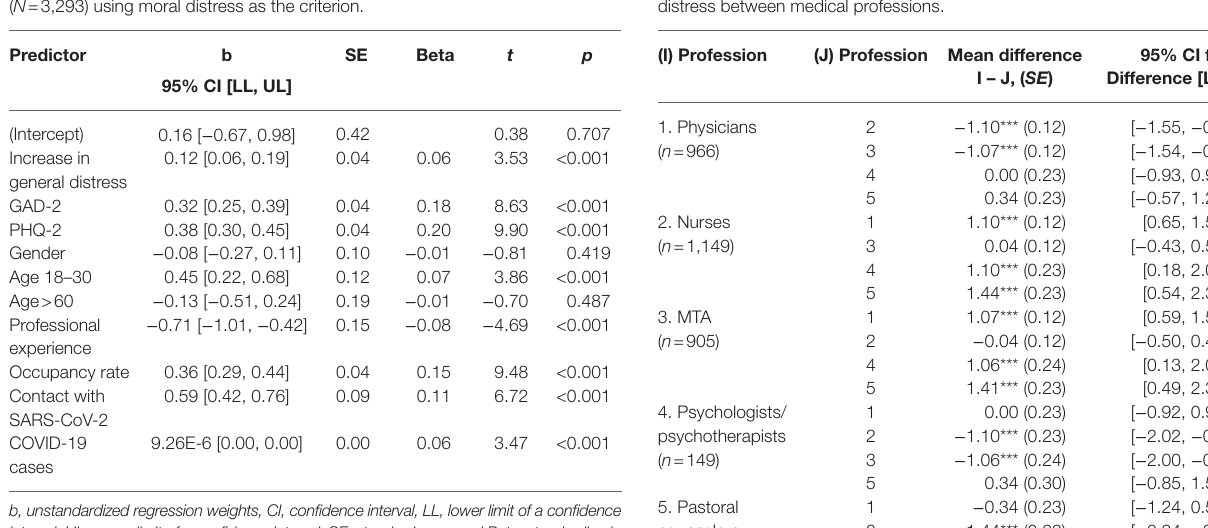
TABLE 5 | Games-Howell post-hoc test for pairwise comparisons of moral distress between medical professions. (I) Profession